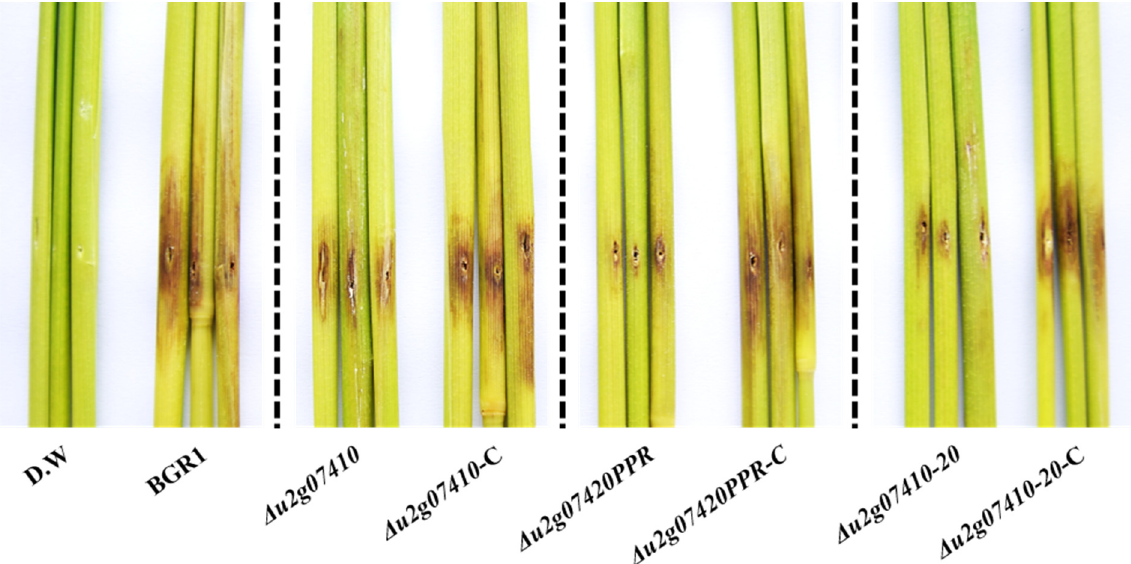
Figure 5. In vivo pathogenicity assay at the vegetative stage to assess the virulence of ∆ u2g07410 , ∆ u2g07420PPR , and ∆ u2g07410-20 . Wild-type and mutant strains were inoculated in the stems of rice plants. Representative of three replicates. Disease symptoms at 8 days post-inoculation. Distilled water (D.W) was used as the negative control.